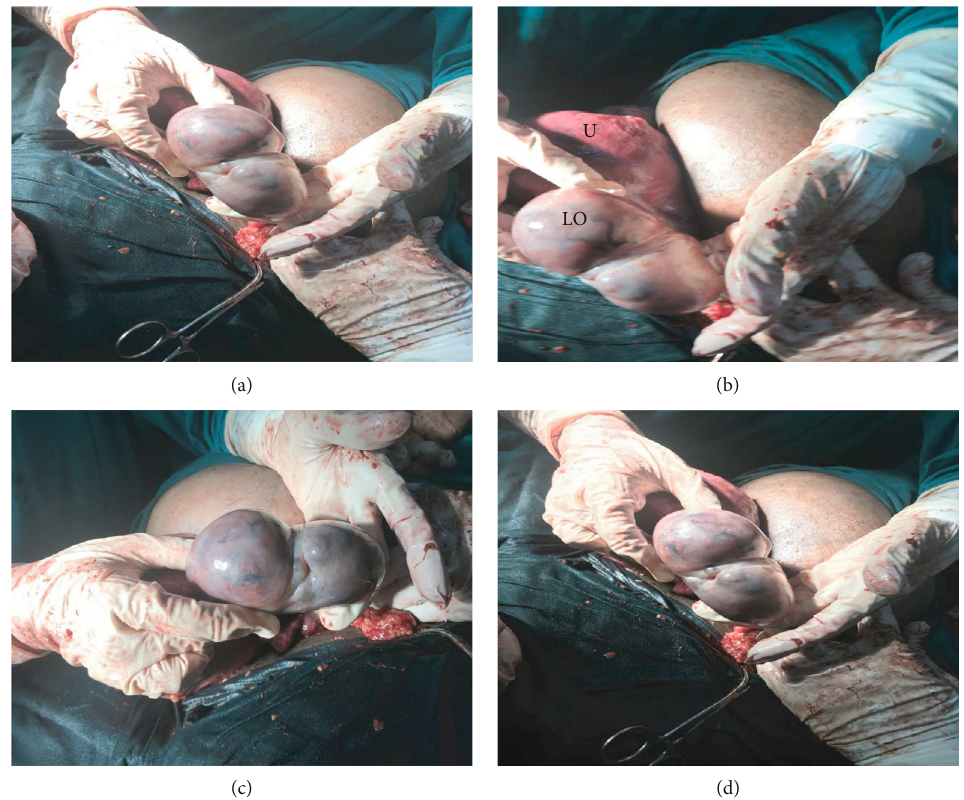
Figure 1: (a – d) Photographs showing grossly enlarged left ovary. (b) Demonstrates the relations of the enlarged left ovary (LO) to the uterus